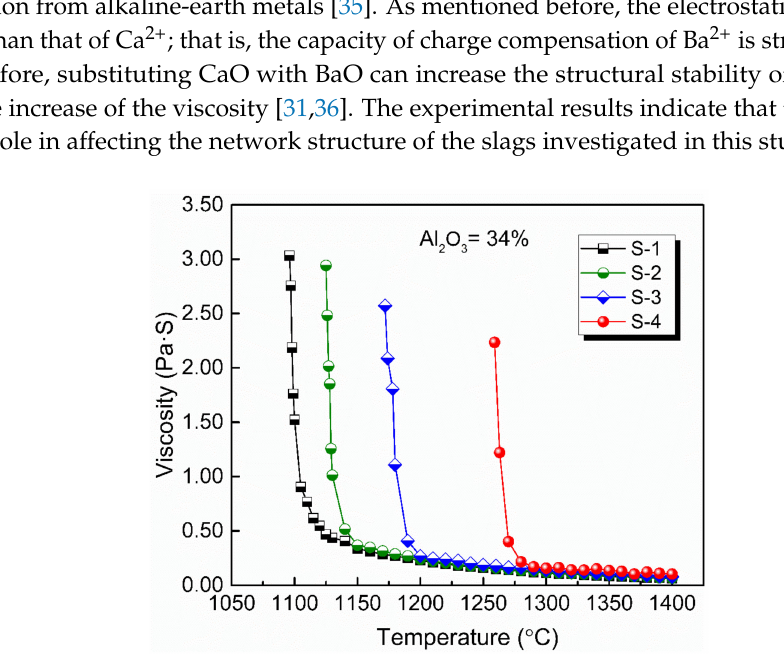
Figure 2. Viscosity–temperature curves of experimental slags with 34 wt % Al 2 O 3 and various BaO/CaO ratios.